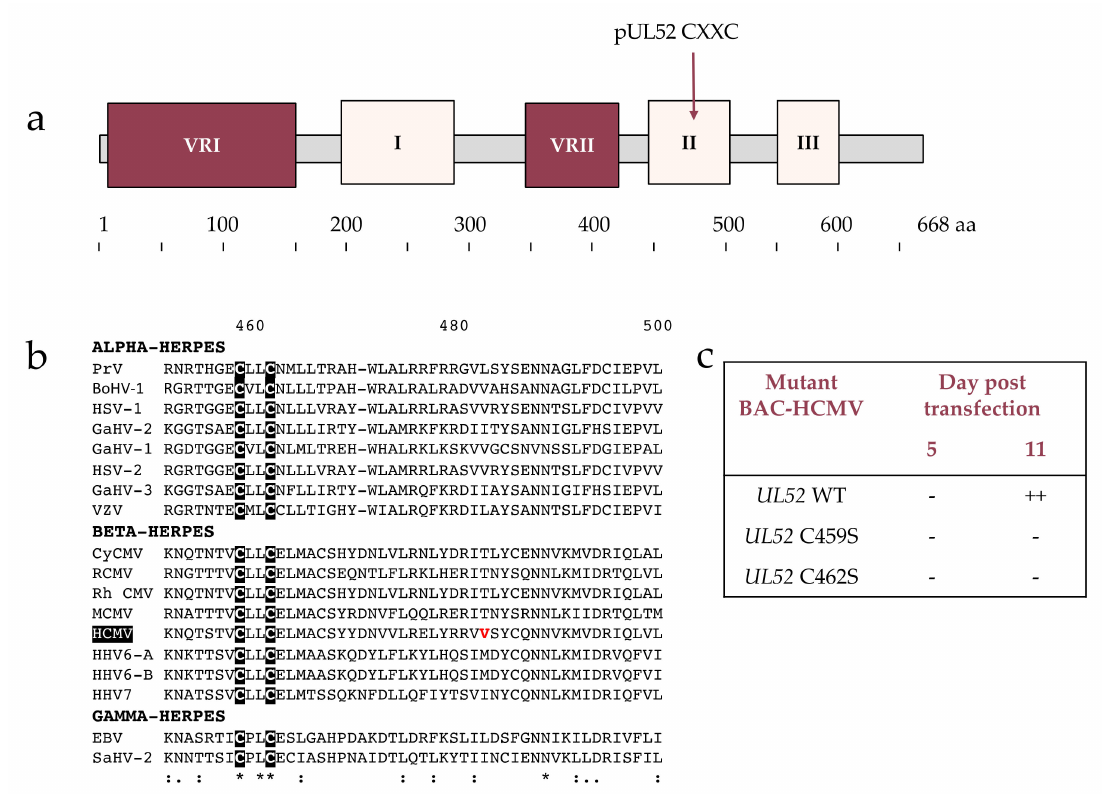
Figure 4. CXXC-like motif in conserved Region II. ( a ) Structure of HCMV pUL52 with a CXXC motif. ( b ) Sequence alignment of the conserved region II from 18 herpesviruses and residues involved in a CXXC motif. Sequence numbering is consistent with that of HCMV reference strain AD169 residues. Key residues involved in the formation of the CXXC motif are shown as white letters on black background. ( c ) Impact of HCMV-BAC- UL52 mutants on growth in cell culture at day 11 (fibroblasts MRC-5). VRI and VRII: variable regions I and II. aa: amino